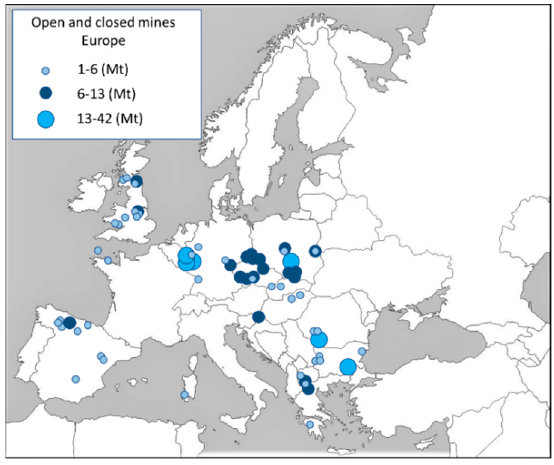
Figure 1. Coal mines in the EU by mine